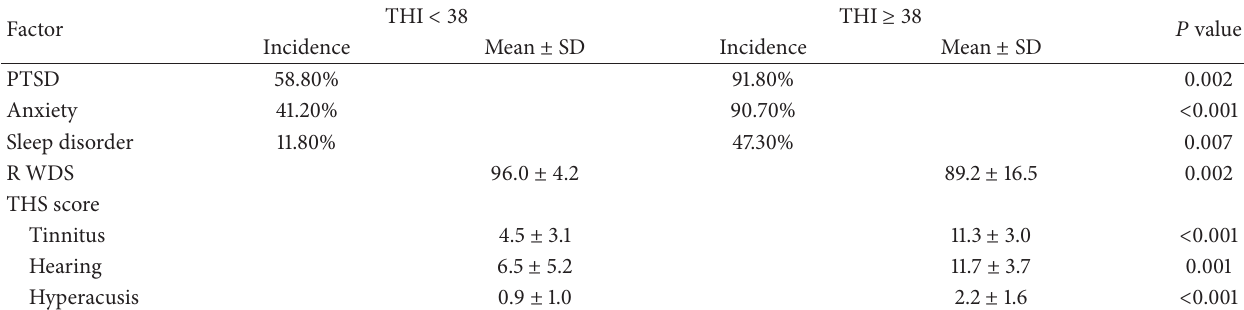
Table 3: Significant differences between tinnitus severity groups. THI: Tinnitus Handicap Inventory, SD: standard deviation, PTSD: